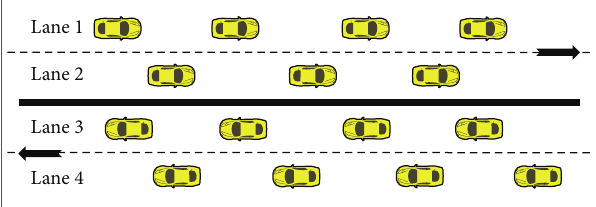
Figure 1: Indian four-lane express